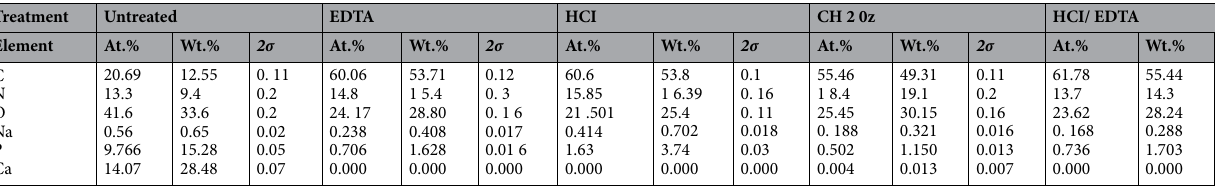
Table 3. Elemental analysis from energy dispersive X-ray spectroscopy for untreated specimens, EDTA (ethylene-diamine tetraacetic acid), formic acid (CH 2 O 2 ), hydrochloric acid (HCl), and HCl/EDTA mixture treated samples. Both atomic and weight percentages are provided. The relative standard deviations are given as 2 σ